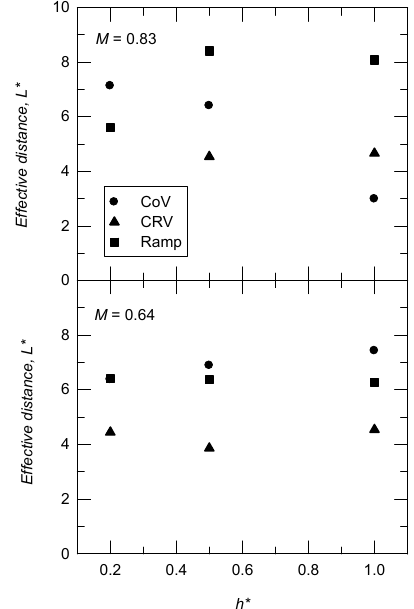
Figure 12. Downstream pressure gradient. The effectiveness of VGs depends on their location upstream of the region to be controlled. The value of L is normalized by δ ( L* = L / δ ), as shown in Figure 13. For M = 0.83, L* ranges from 3.0 to 8.4. The effect of VG configuration varies. For CoV VGs, there is a decrease in L* as h* increases. This is consistent with the effect of h* on the downstream favorable pressure gradient, as shown in Figure 11. The value for L * (=8.4) for Ramp VGs is a maximum for h* = 0.5. The value of h* has a slight effect on L* for CRV VGs. For M = 0.64, the effect of h* on L* is less significant for all three VG configurations. The device-induced vortices in the presence of CoV VGs extend for a longer distance.